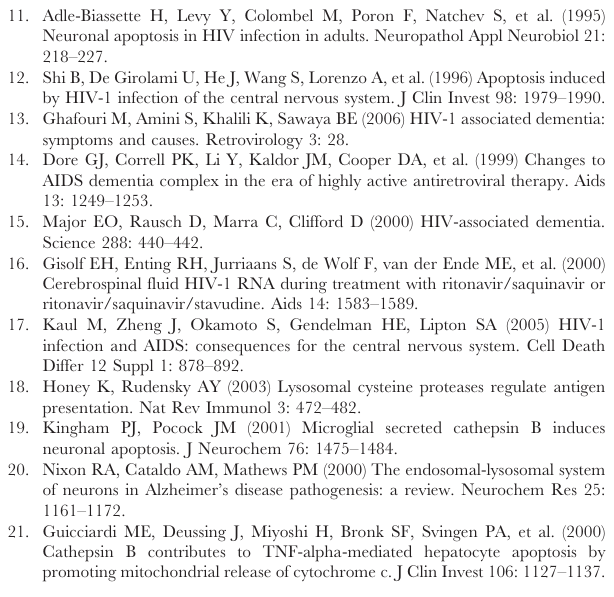
Figure S1 Intracellular expression of cathepsin B and its inhibitors after HIV infection in macrophages. HIV replication was measured in the cell supernatants by p24 viral antigen ELISA (A). In vitro HIV-infected macrophages from 4 different donors (solid circles) showed an increase in HIV replication at 12 dpi (p , 0.001; A). Differences in expression of cathepsin B, cystatin B, and cystatin C at 6, 9 and 12 dpi; panels B, C and D and E) were determined by Western blot analysis. Aliquots of 30 m g of total protein were loaded per line blotted and probed with antibodies against cathepsin B, cystatin B, cystatin C (B). The density of the bands was normalized (C, D and E) against that of b -tubulin (A bottom panel). Normalized data are presented for cathepsin B (open bars), cystatin B (grey bars), and cystatin C (solid bars). Levels of cathepsin B in HIV-infected and uninfected cells remained unchanged through infection (C, D and E).